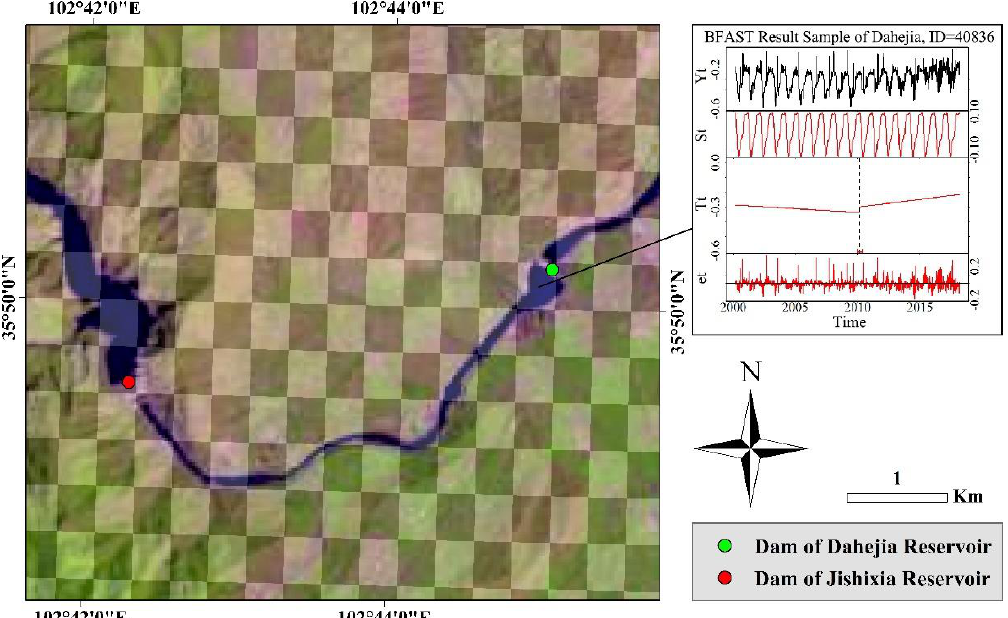
Figure 8. Unfiltered false break points detected in terrestrial areas away from the Yellow River ( a ), near Liujiaxia reservoir ( b ), and in the Yellow River ( c ). From the plots of trend component, what could be discovered is that the values in trend components jumped to a little higher value than the threshold we set. With a little higher value of threshold, these false break points would be effectively eliminated, which is the inherent disadvantage of threshold-based elimination.